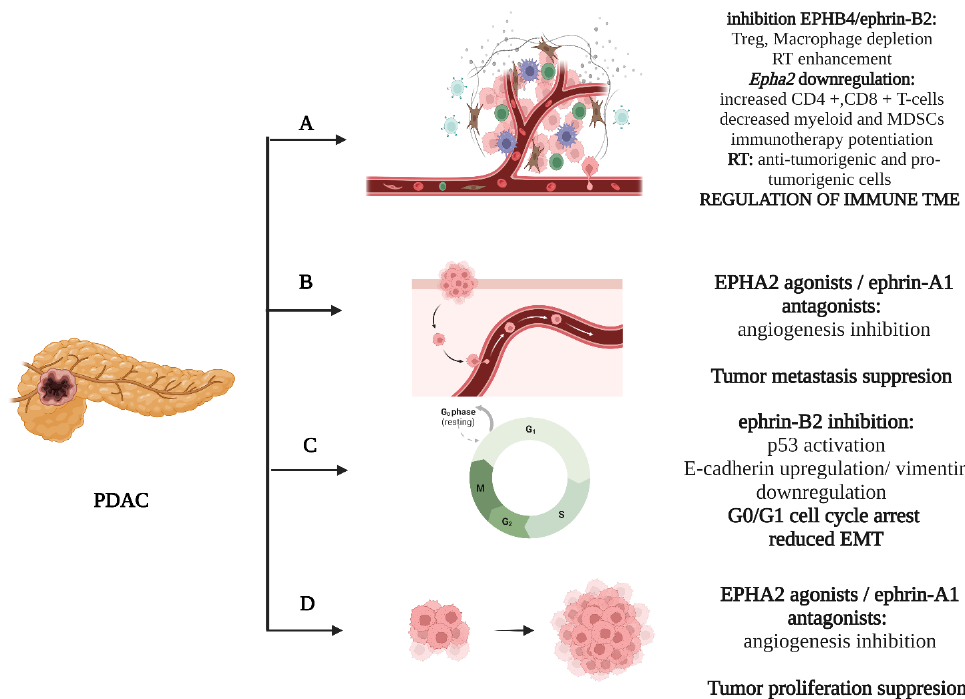
Figure 2. Basic mechanisms influenced by the EPH/ephrin system: ( A ) RT, EPHA2 and EPHB4/ephrin-B2 shape the immune cellular population of TME. ( B ) EPHA2/ephrin-A1 influences the metastatic potential of cancer cells. ( C ) Ephrin-B2 regulates G0/G1 cell cycle transition. ( D ) EPHA2/ephrin- A1 induce tumor growth. Created with